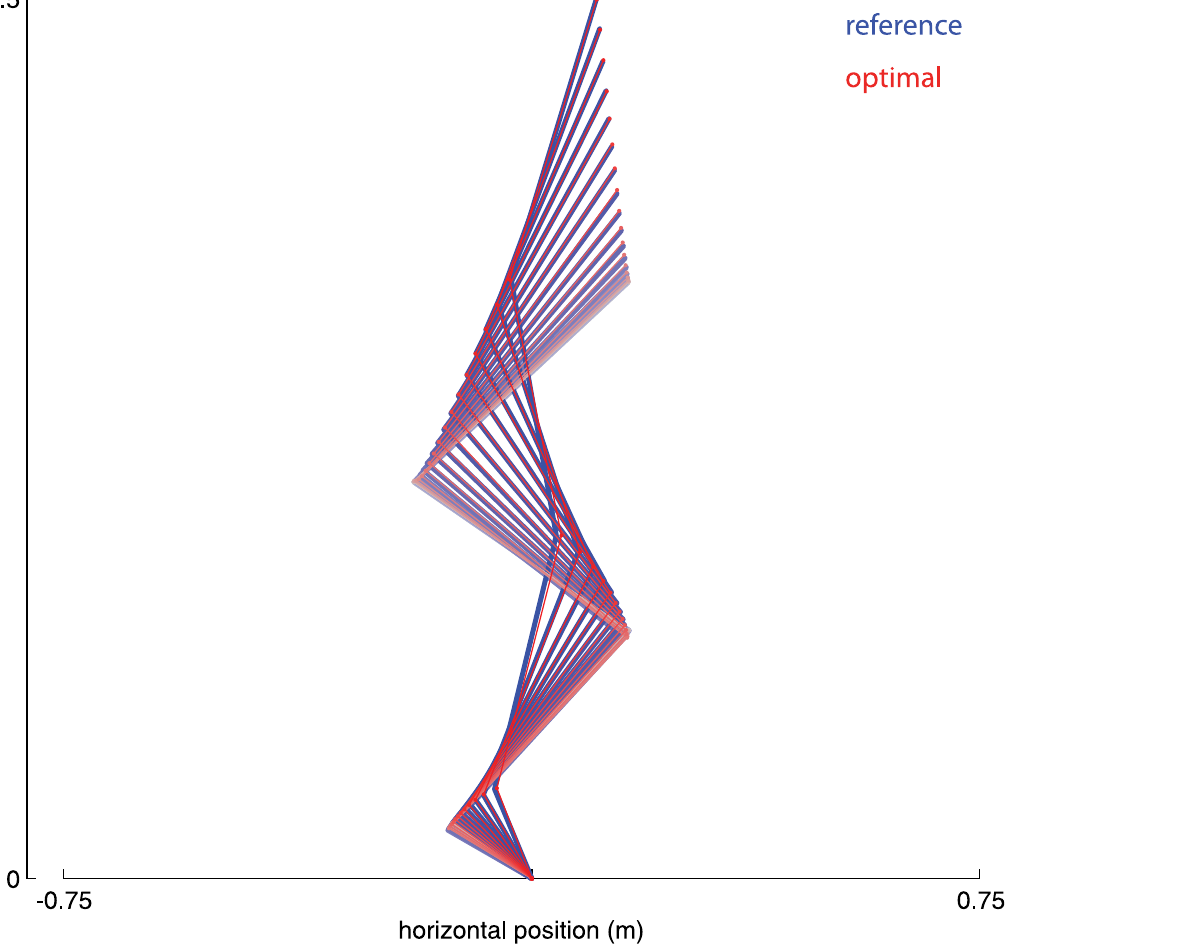
Fig 2. Segment kinematics, sagittal plane view. Plotted are the foot, shank, thigh, and trunk during the push-off for both reference (blue) and optimal (red) models. Segments have been plotted at 5% increments of the push-off phase. Percentages reflect the relative increase in jump height over the reference model. COM = height of center of mass.